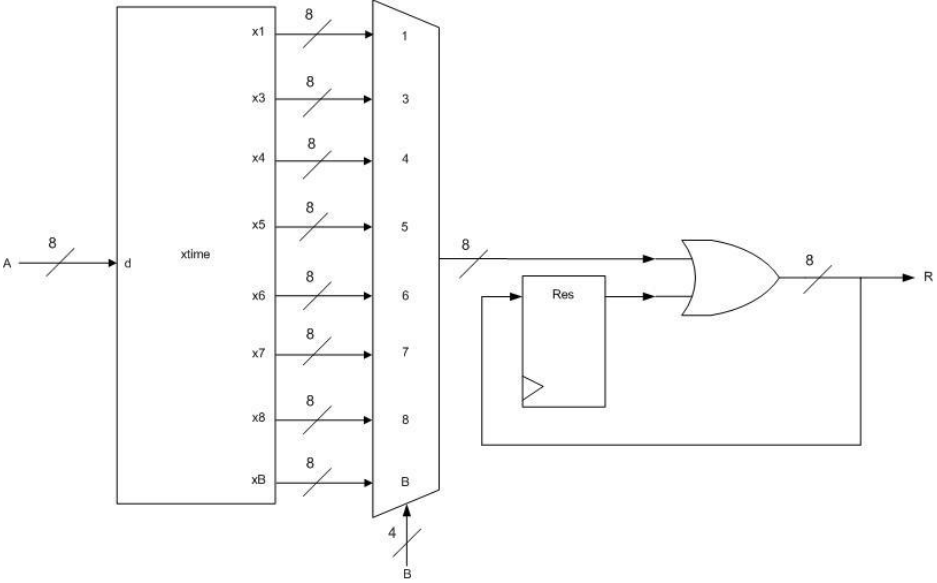
Fig. 13 Processing element